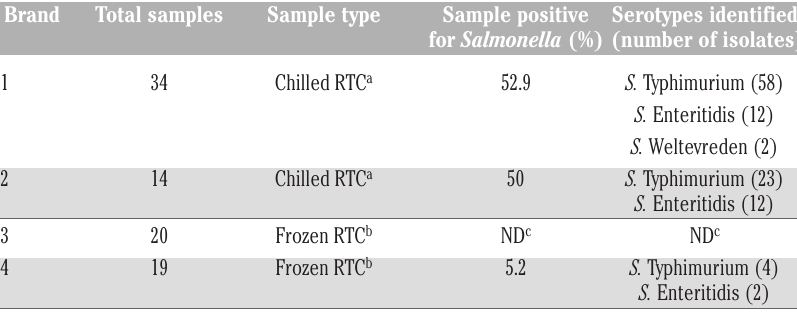
Table 1. Isolation of Salmonella spp. from different brands of